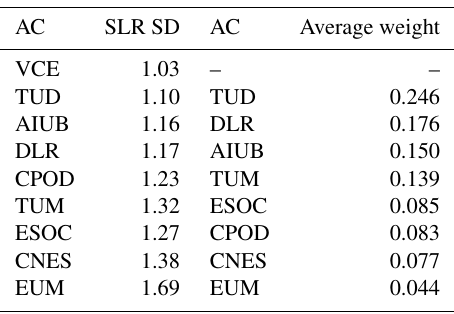
Table 9. Comparison of SLR SD (increasing) to average weights